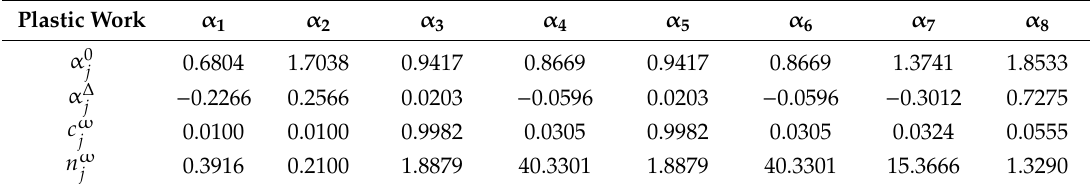
Table 8. Evolution coefficients for the parameters of the plastic potential of the niobium sheet. Plastic Work